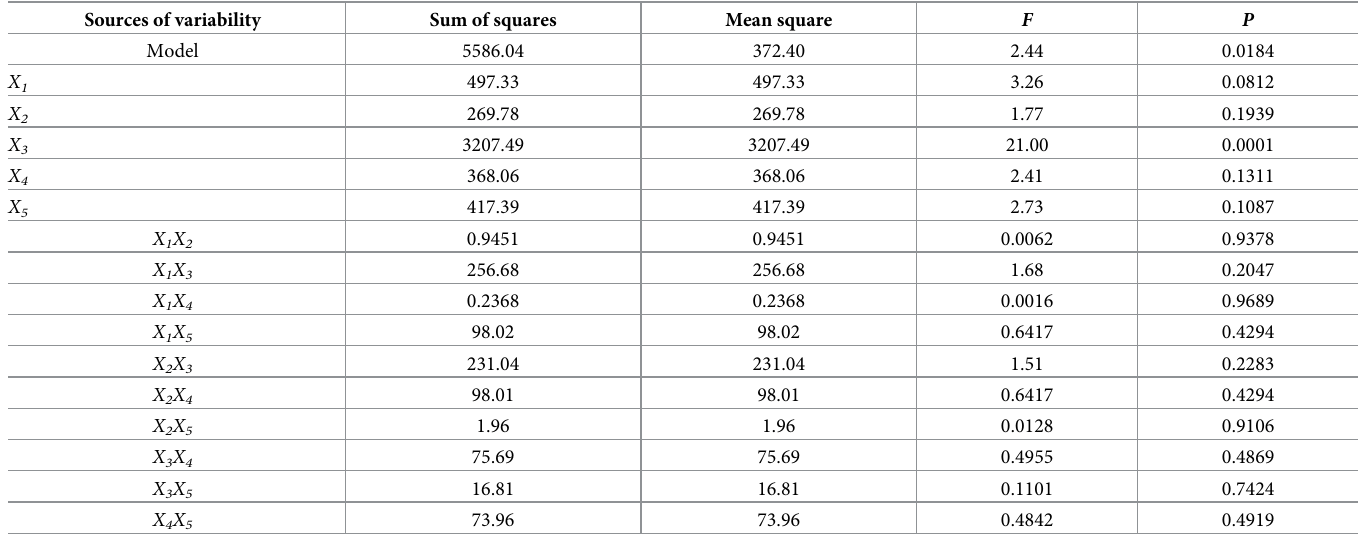
Table 4. Analysis of variance of 60min disintegration regression